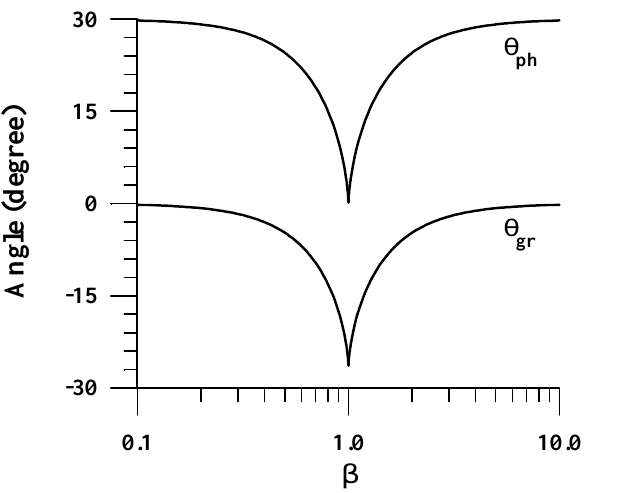
Fig. 5. Maximal group velocity of a slow magnetoacoustic wave (curve A ) and its projection to the external magnetic field (curve B ) versus the β -parameter, given in the logarithmic scale. The group velocity is normalised by the Alfv´en